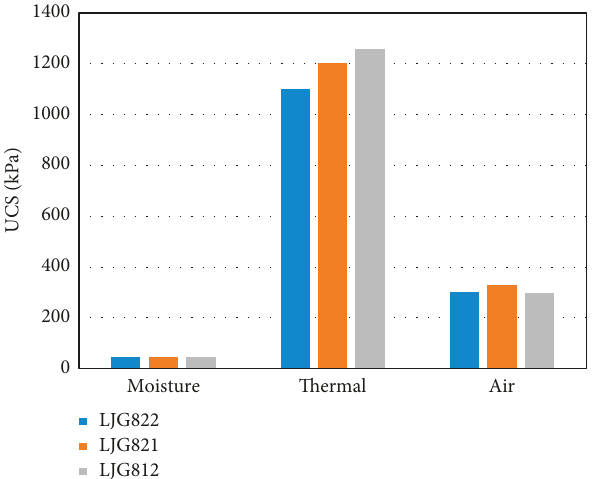
Figure 8: UCS of stabilized soil subjected to different curing conditions.